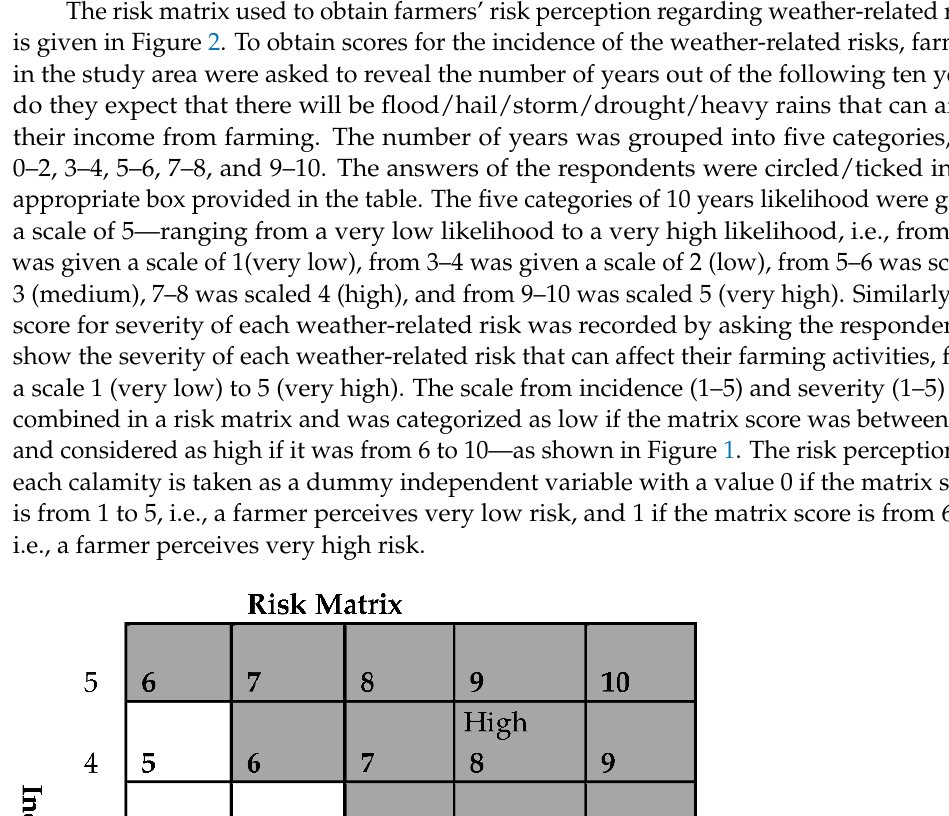
Table 3. Total scores of farmers’ risk perception of the weather -related risks.